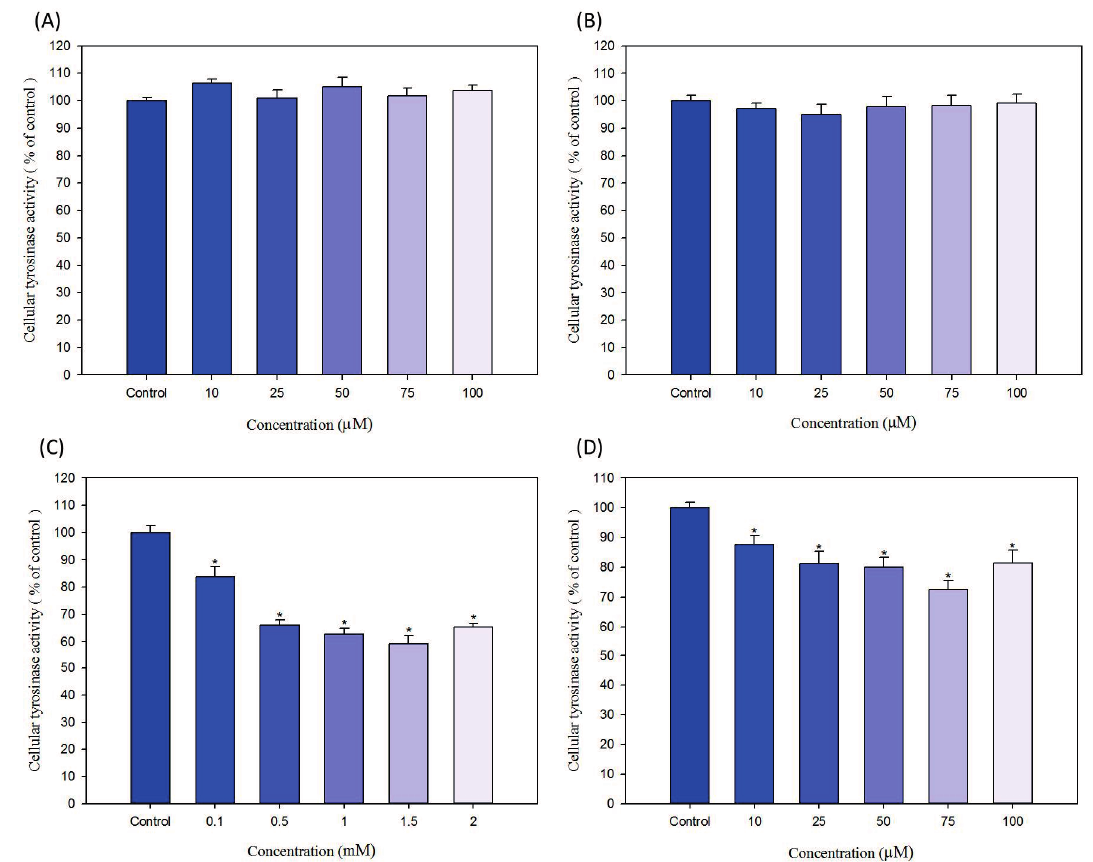
Figure 5. In vitro effects of hair dyes on the activity of B16-F10 cellular tyrosinase. ( A ) ammonium persulfate; ( B ) sodium persulfate; ( C ) resorcinol and ( D ) lawsone. Each value is expressed as the mean ± S.E. ( n = 6). * p < 0.05 compared with the